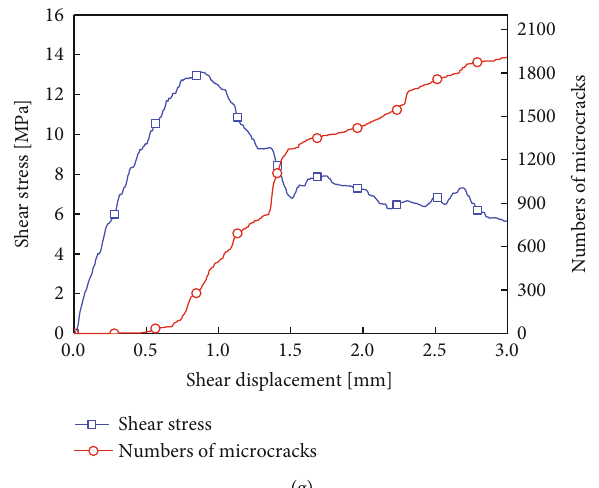
Figure 14: Variation curves of shear stress and microcrack numbers with shear displacement: (a) joint 1; (b) joint 2; (c) joint 3; (d) joint 4; (e) joint 5; (f) joint 6; (g) joint 7.